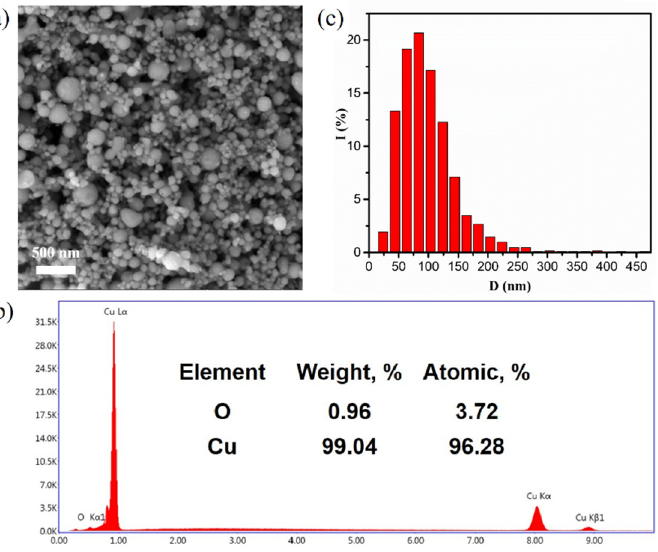
Figure 3. SEM image ( a ), EDS results ( b ) and Statistical diagram ( c ) of particle size of Cu nanoparticles.